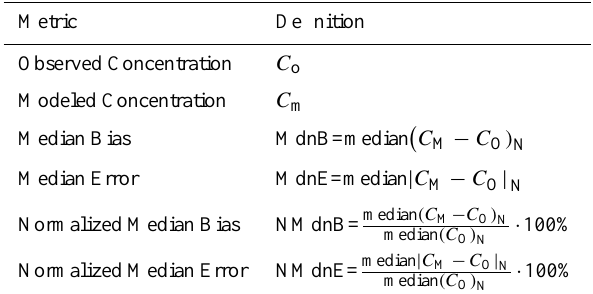
Table 2. Definition of statistical metrics used to compare observed and simulated O 3 , aerosol species and wet deposition